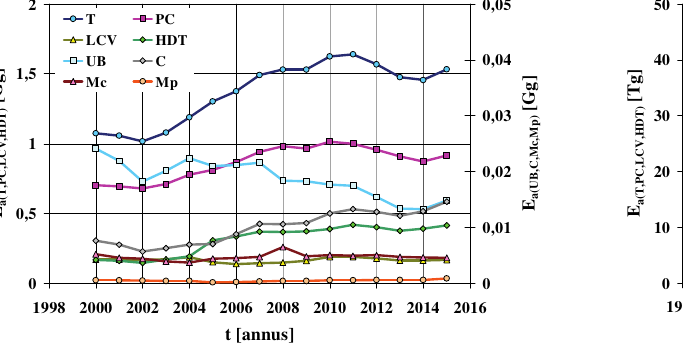
Fig. 18. National annual emission of carbon dioxide per cumulated vehicle